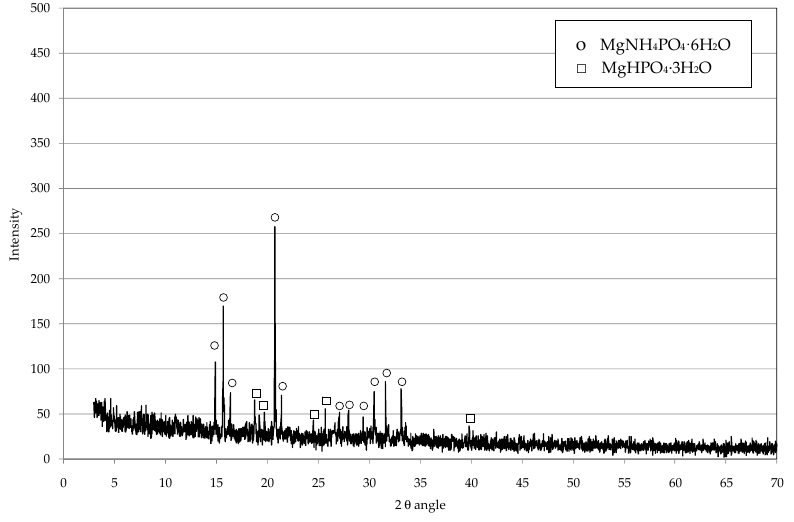
Figure 11. Diffractogram of precipitate produced by reusing the struvite decomposition residues for the treatment of raw leachate.